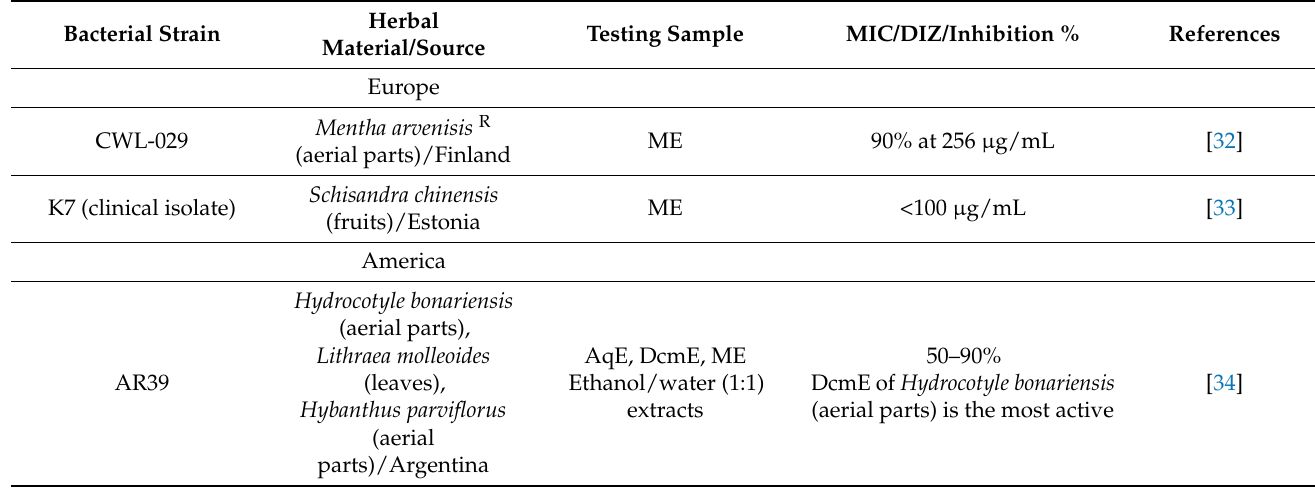
Table 2. Medicinal plants tested for the antimicrobial effect against Chlamydia pneumoniae